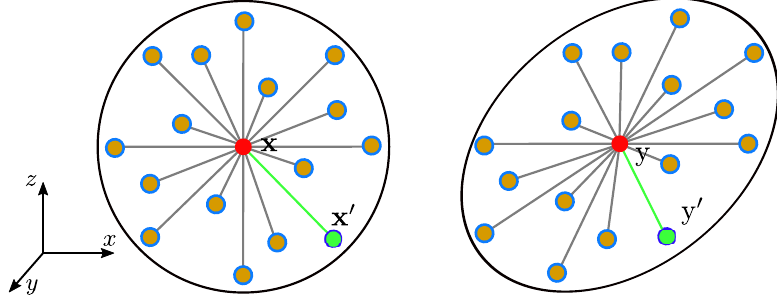
Figure 1. Kinematics of peridynamic poroelastic framework of a material point x and its neighboring material points: ( left ) the initial configuration and ( right ) the current configuration of the solid-fluid mixture. The red dots represent solid material points and the blue circles represent water material